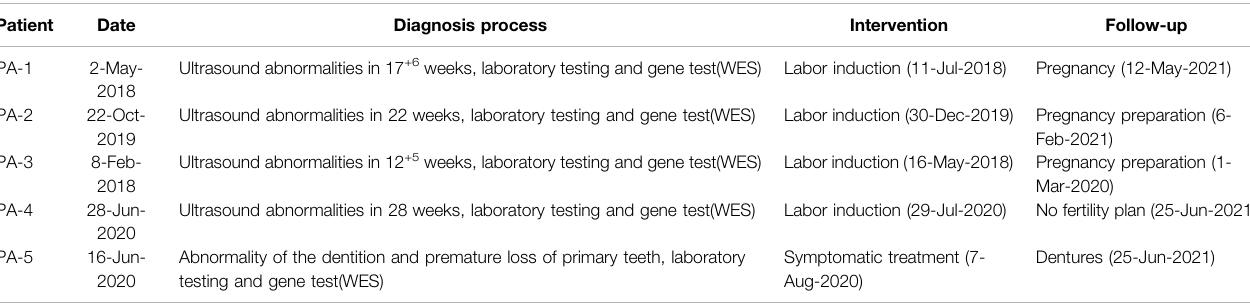
TABLE 3 | A timeline with diagnosis and